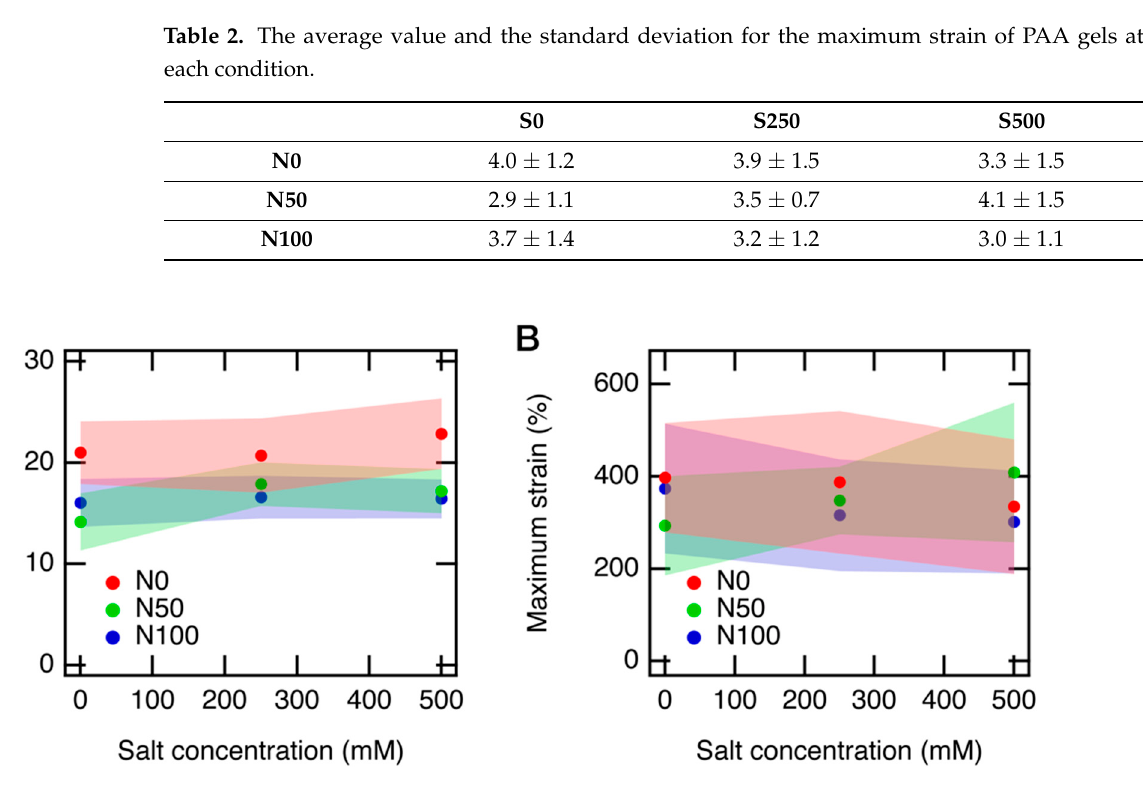
Table 2. The average value and the standard deviation for the maximum strain of PAA gels at each condition.